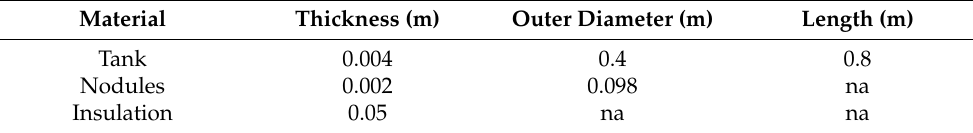
Table 4. System geometry.